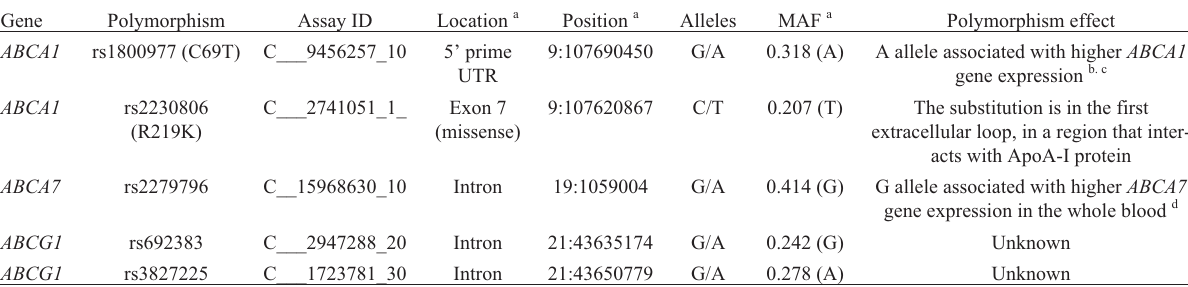
Table 1 - ABC genes polymorphisms investigated in this